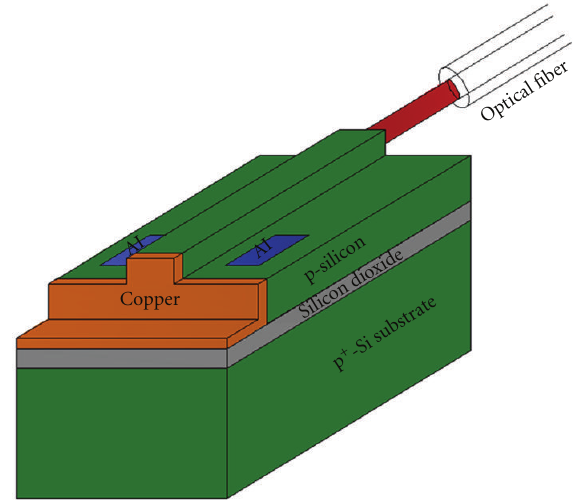
Figure 6: Schematic view of the proposed photodetector integrated with SOI